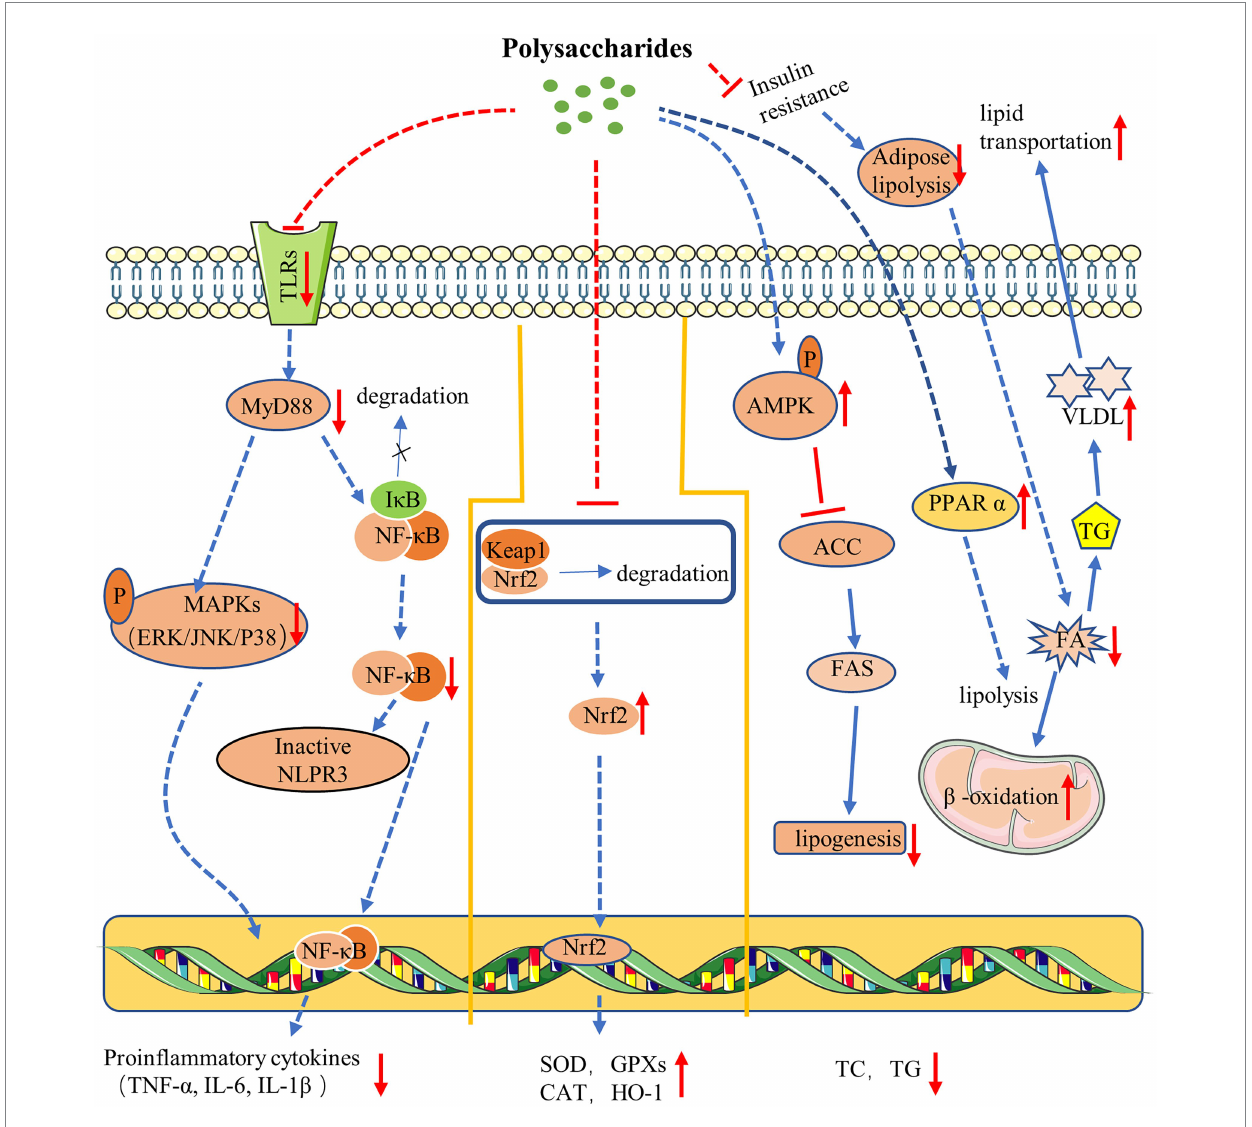
FIGURE 1 Mechanism of polysaccharides action on NAFLD. Polysaccharides ameliorate NAFLD via anti-inflammation (left) . Polysaccharides improve NAFLD via antioxidation (middle) . Polysaccharides exert therapy effect on NAFLD via regulating glucose and lipid metabolism (right)